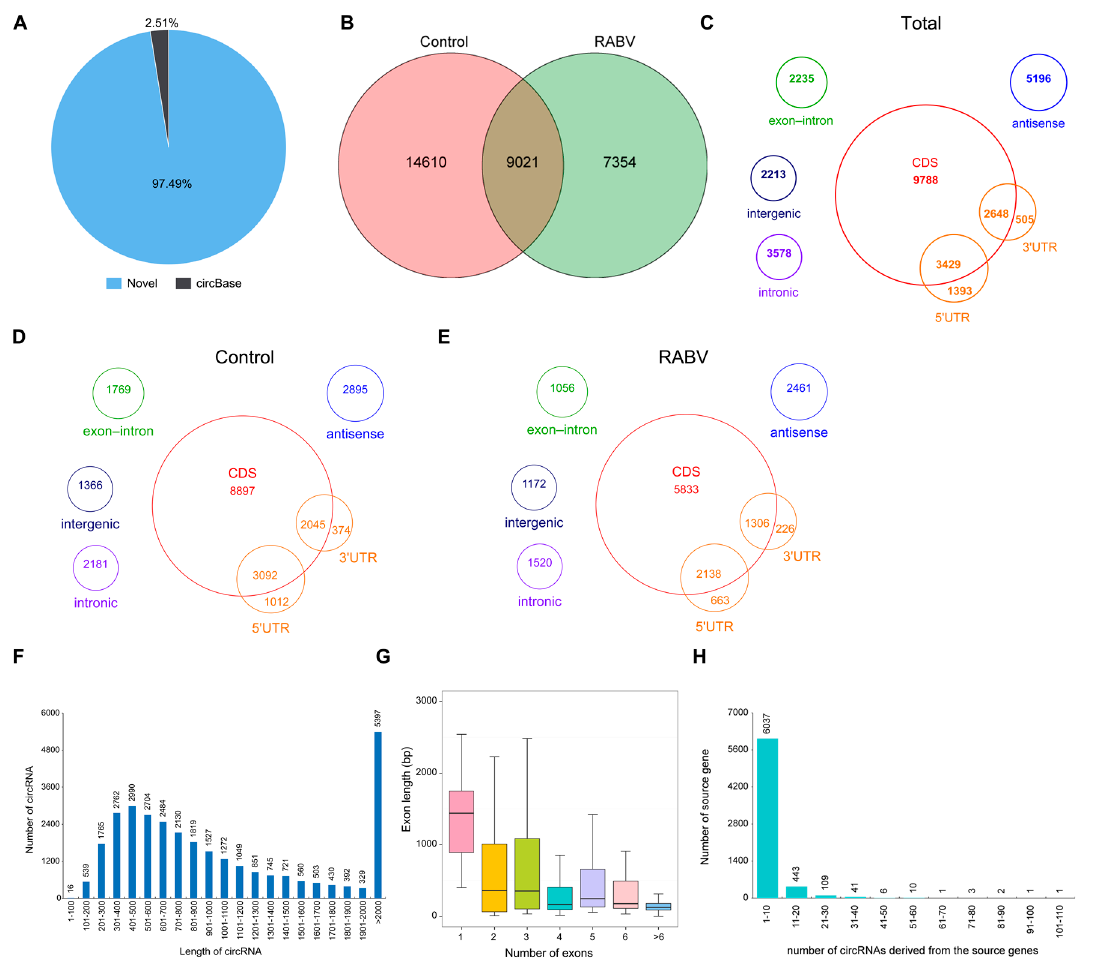
Figure 2. Profiling of circular RNAs in RABV- and DMEM-infected mice brains. ( A ) Pie chart showing the number of known circRNAs in Circbase and the new identified circRNAs; ( B ) The total number of circRNAs detected in the experimental and control groups; ( C ) Genomic features of circRNAs in both groups; ( D ) Genomic features of circRNAs in the control group; ( E ) Genomic features of circRNAs in the experimental group; ( F ) Illustration of the identified circRNAs length; ( G ) Box plot illustrating the length of exon that circularizes into circRNAs; ( H ) Bar plot showing that one gene could generate multiple circRNAs.